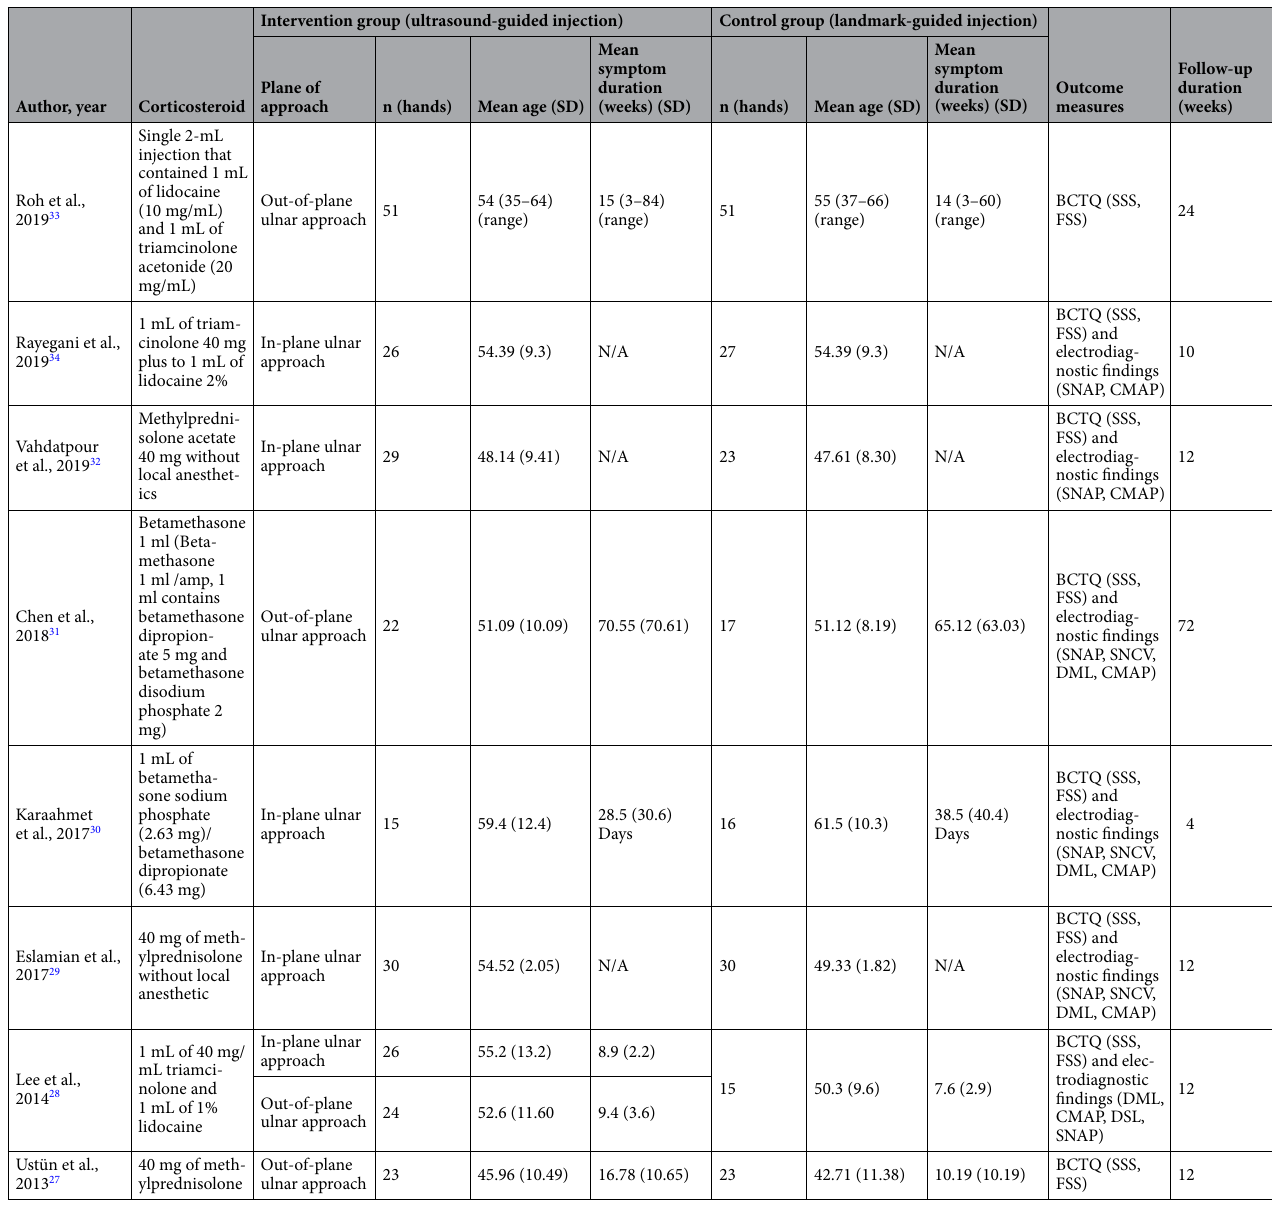
Table 1. Characteristics of the selected randomized controlled trials. N/A not applicable, BCTQ Boston Carpal Tunnel Syndrome Questionnaire, SSS Symptom Severity Scale, FSS Functional Status Scale, SNAP sensory nerve action potential, CMAP compound muscle action potential, SNCV sensory nerve conduction velocity, DML distal motor latency, DSL distal sensory latency, SD standard